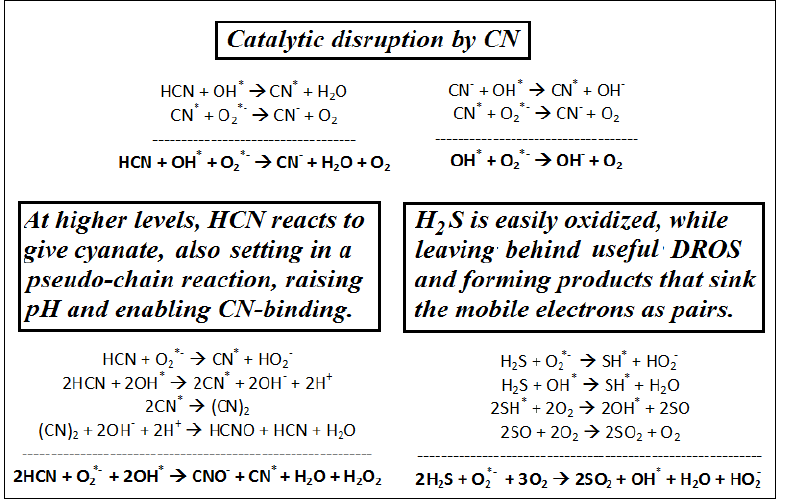
S in physiological/ 2